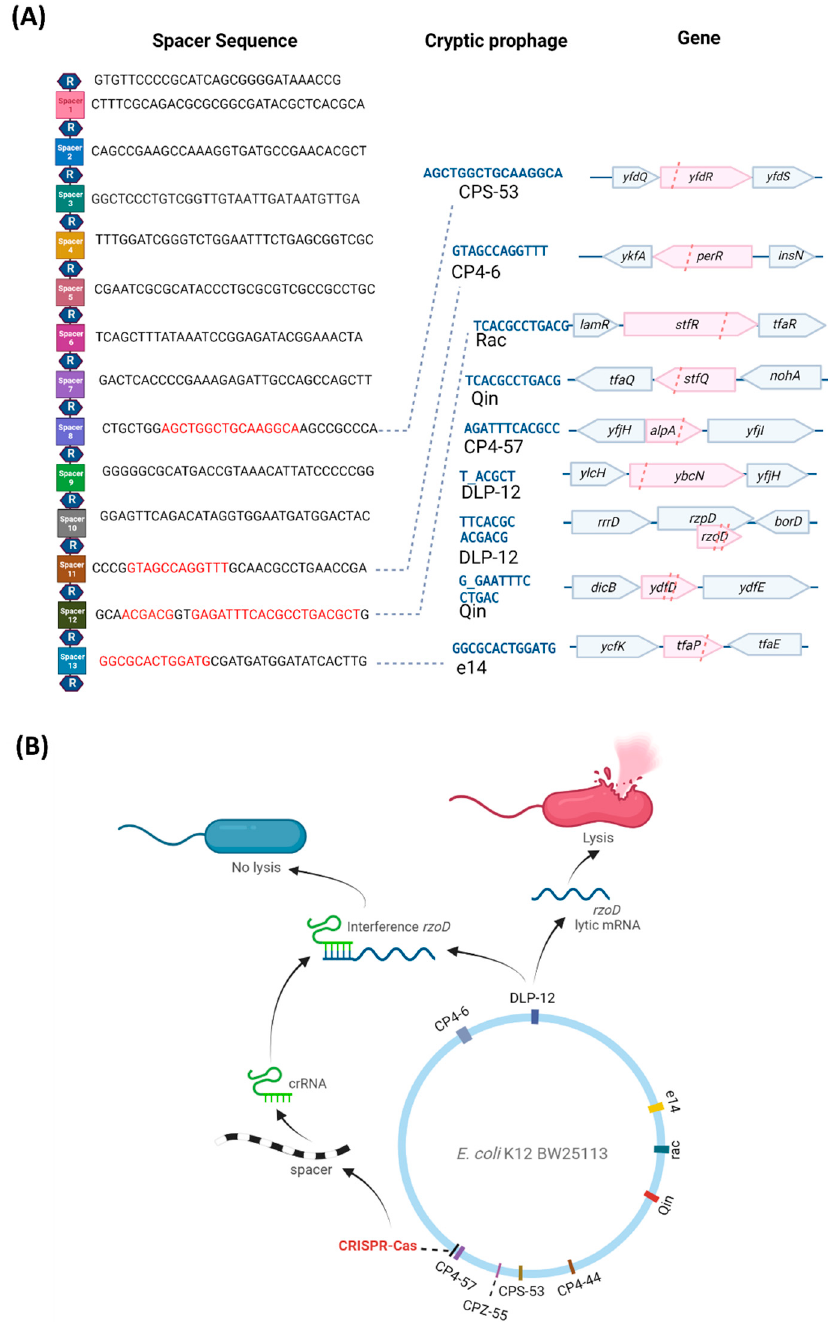
Figure 2. E. coli CRISPR-Cas spacer sequences and lytic gene inhibition mechanism. ( A ) The 14 repeat (R, hexagon) and 13 spacer (squares) sequences of the CRISPR-Cas system (from the iap to cas2 part of the E. coli genome) showing the cryptic prophage spacer matches (red text) and prophage DNA protospacer sequences (blue text), which include matches to seven of the nine cryptic prophages (CPS-53, CP4-6, Rac, Qin, CP4-57, DLP-12, and e14). Matches indicate mRNA binding to spacer sequences (Figure S8). Pink highlights and pink dashed lines indicate the spacer positions relative to the cryptic prophage genes. ( B ) A schematic for a hypothetical mechanism by which CRISPR-Cas controls cryptic phage lytic genes.